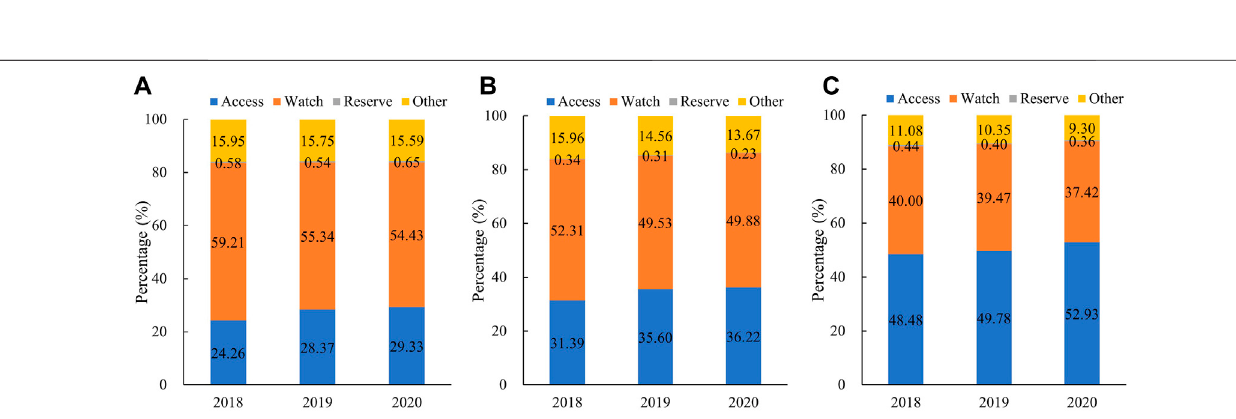
Frontiers in Pharmacology |